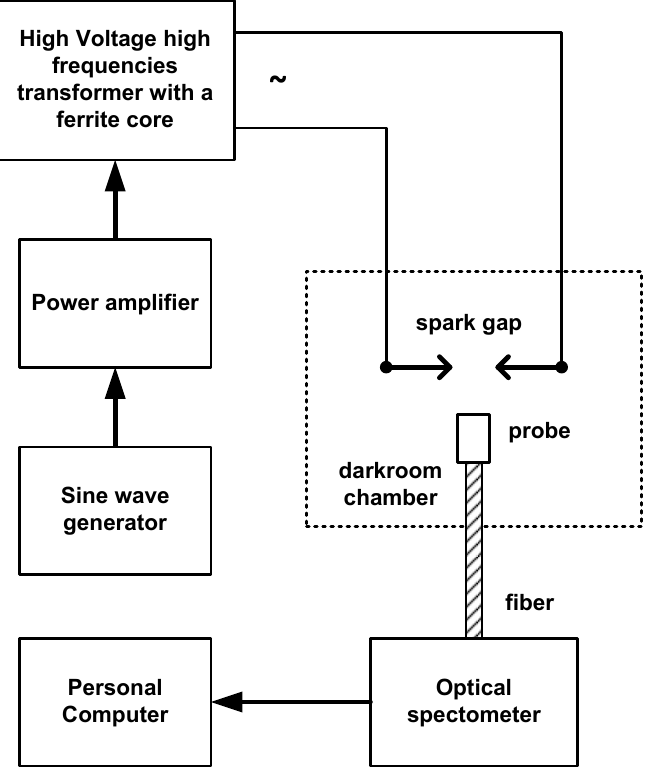
Figure 1. Block diagram of a system to generate an electric arc at a given frequency.